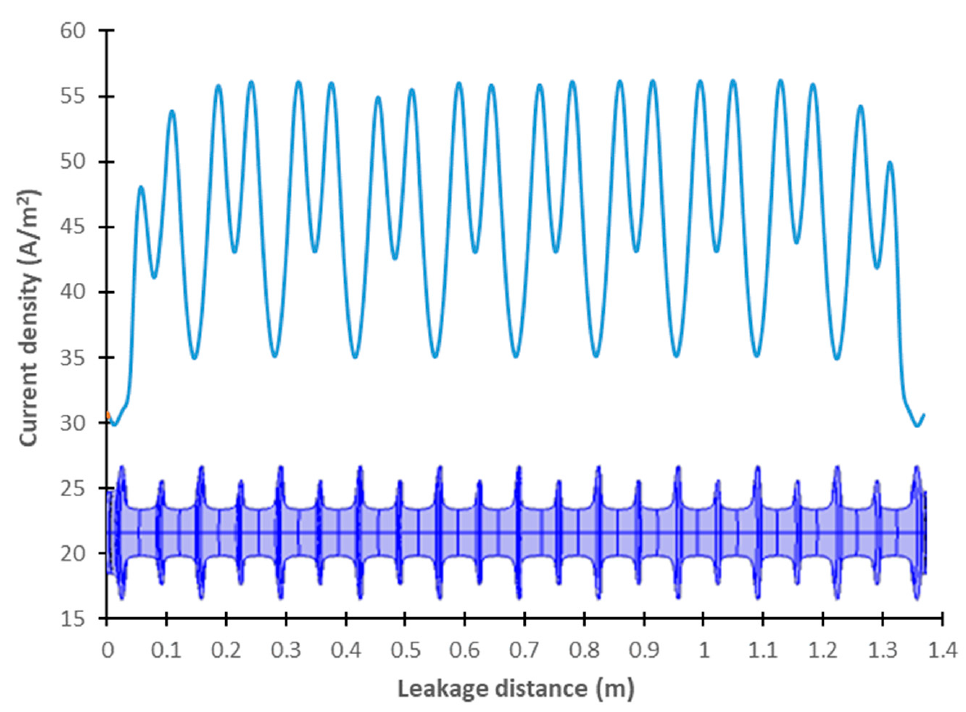
Figure 4. Temperature distribution.